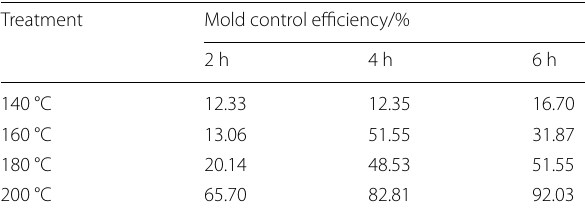
Table 6 The mold control efficiency of oil heat-treated bamboo